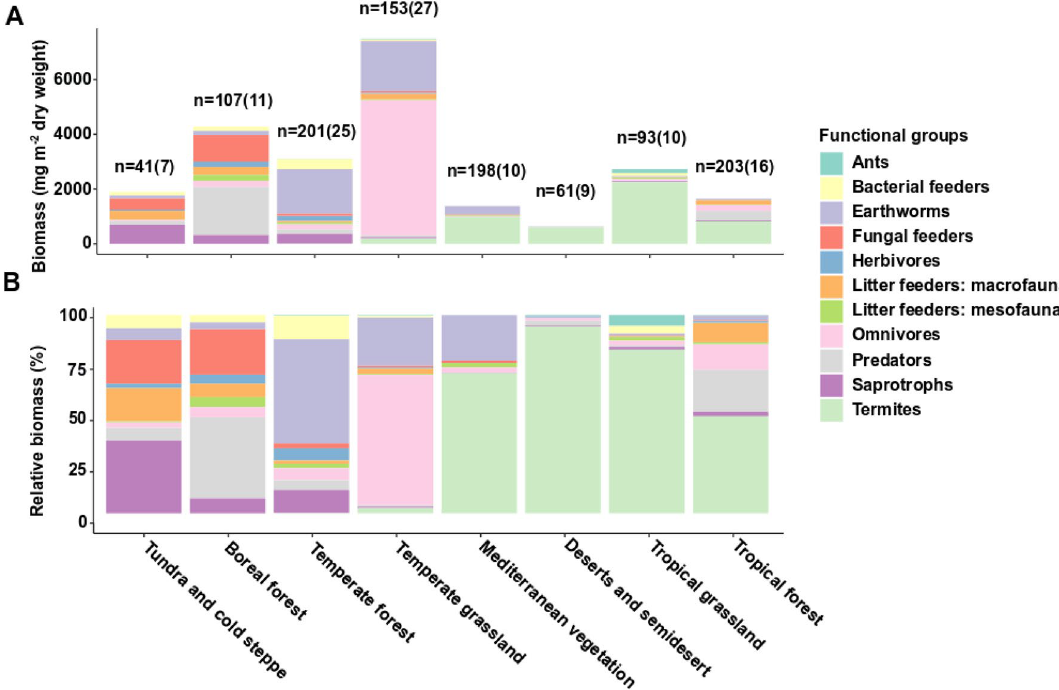
Figure 1. Global distribution among biomes of the biomass ( A ) and the relative biomass ( B ) of soil fauna functional groups. The n refers to number of observations based on individual habitat studies. Number in parentheses refers to number of published